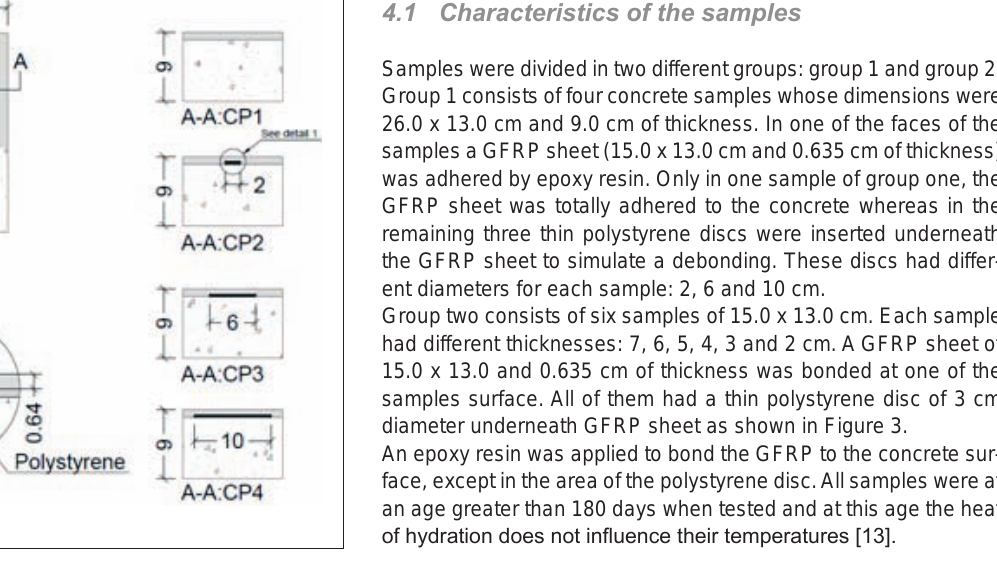
Figure 2 – Samples of group 1 (measurement in